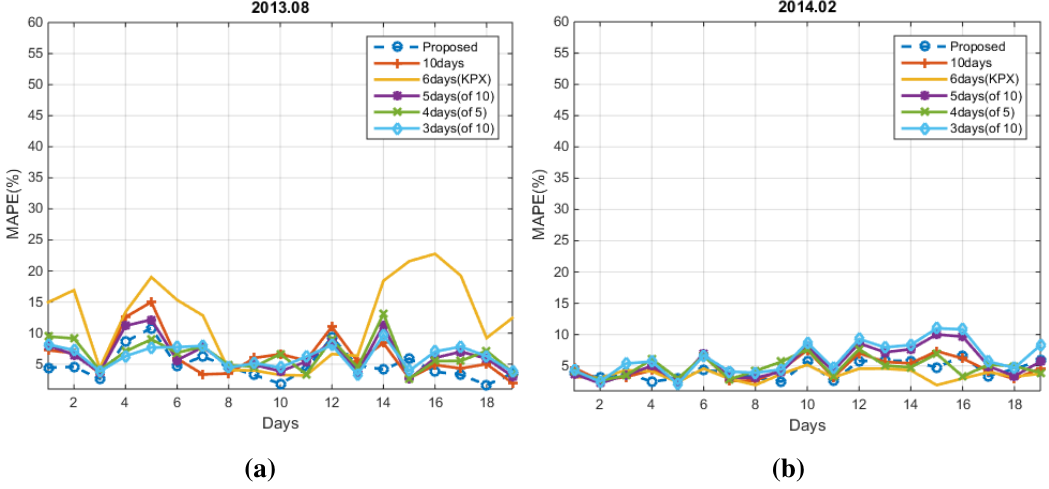
Figure 12. MAPE evaluation of site B in summer season ( a ) and winter season ( b ).